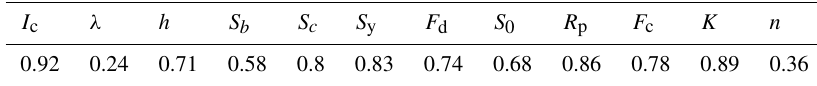
Table 2. Parametric sensitivity results in the QMG model.